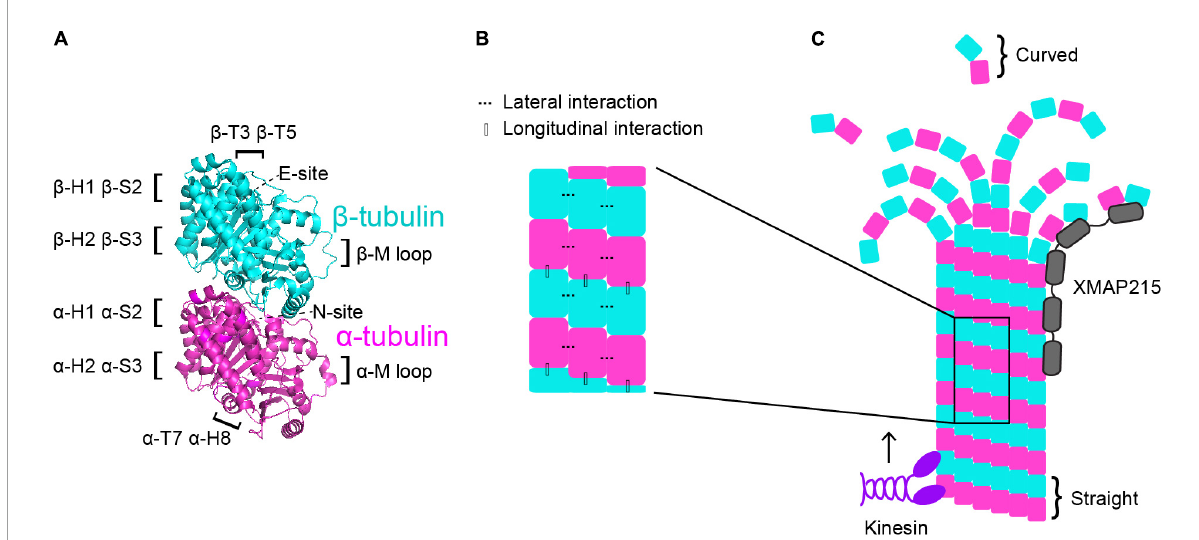
FIGURE1 Microtubule dynamics are regulated at multiple control points. (A) α -tubulin is human TUBA1A in magenta and β -tubulin is human TUBB3 is in cyan (PDB structure: 5JCO). Regions that participate in longitudinal and lateral interactions are described along the sides of the structure. α - and β -tubulin each bind one GTP molecule. The non-exchangeable “N-site” on α -tubulin sits at the intradimer surface and the GTP is not hydrolyzed. The exchangeable “E-site” on β -tubulin is at the interdimer interface and the GTP molecule is hydrolyzed upon incorporation of the heterodimer into the microtubule lattice. (B) Lateral interactions occur between neighboring protofilaments and are illustrated by the dotted lines. Longitudinal interactions occur between at the interdimer interface between two stacked heterodimers. (C) Microtubule-associated proteins (MAPs) and motors can have specific preferences for associating with different segments of microtubules. For example, XMAP215 (gray) associates at microtubule plus ends and kinesins (purple) walk along the lattice toward the plus end. Tubulin undergoes a series of conformational changes. Free, curved heterodimer subsequently straightens as it is assembled into microtubule